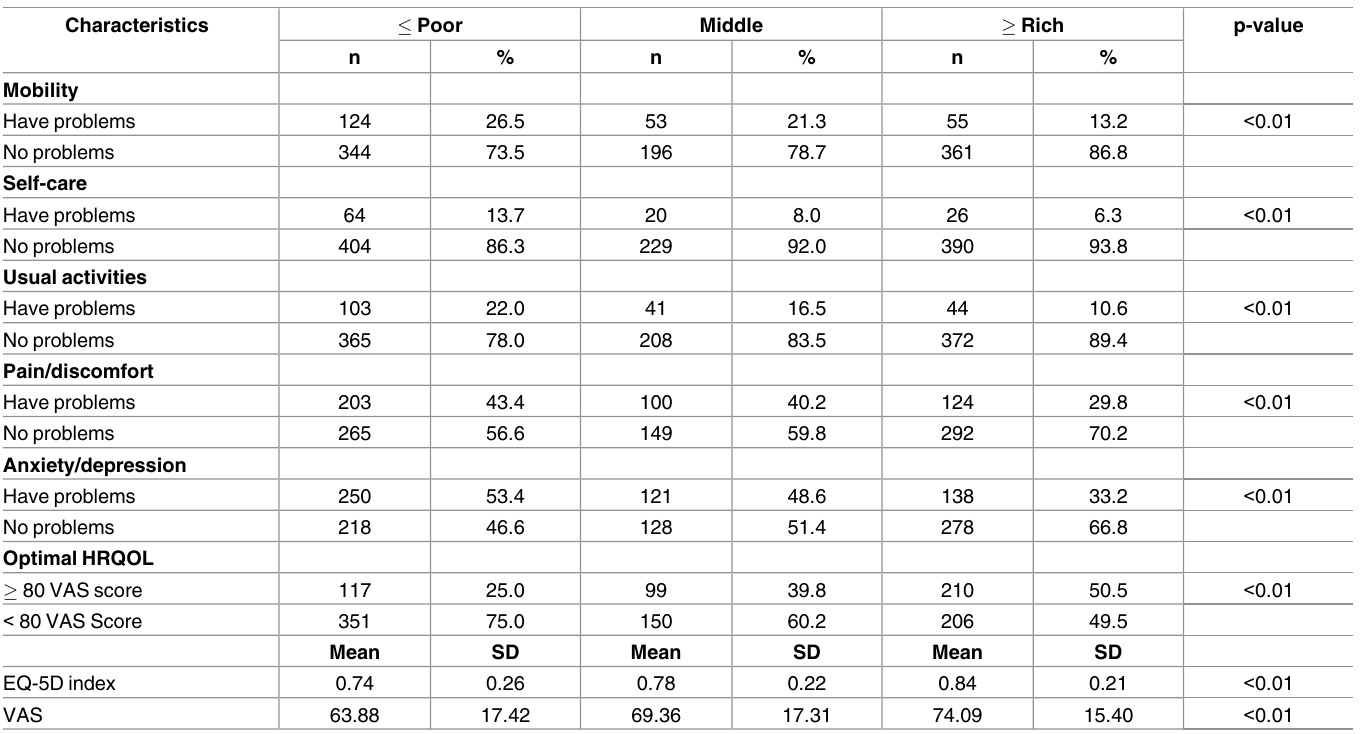
Table 3. HRQOL of respondents by household’s economic